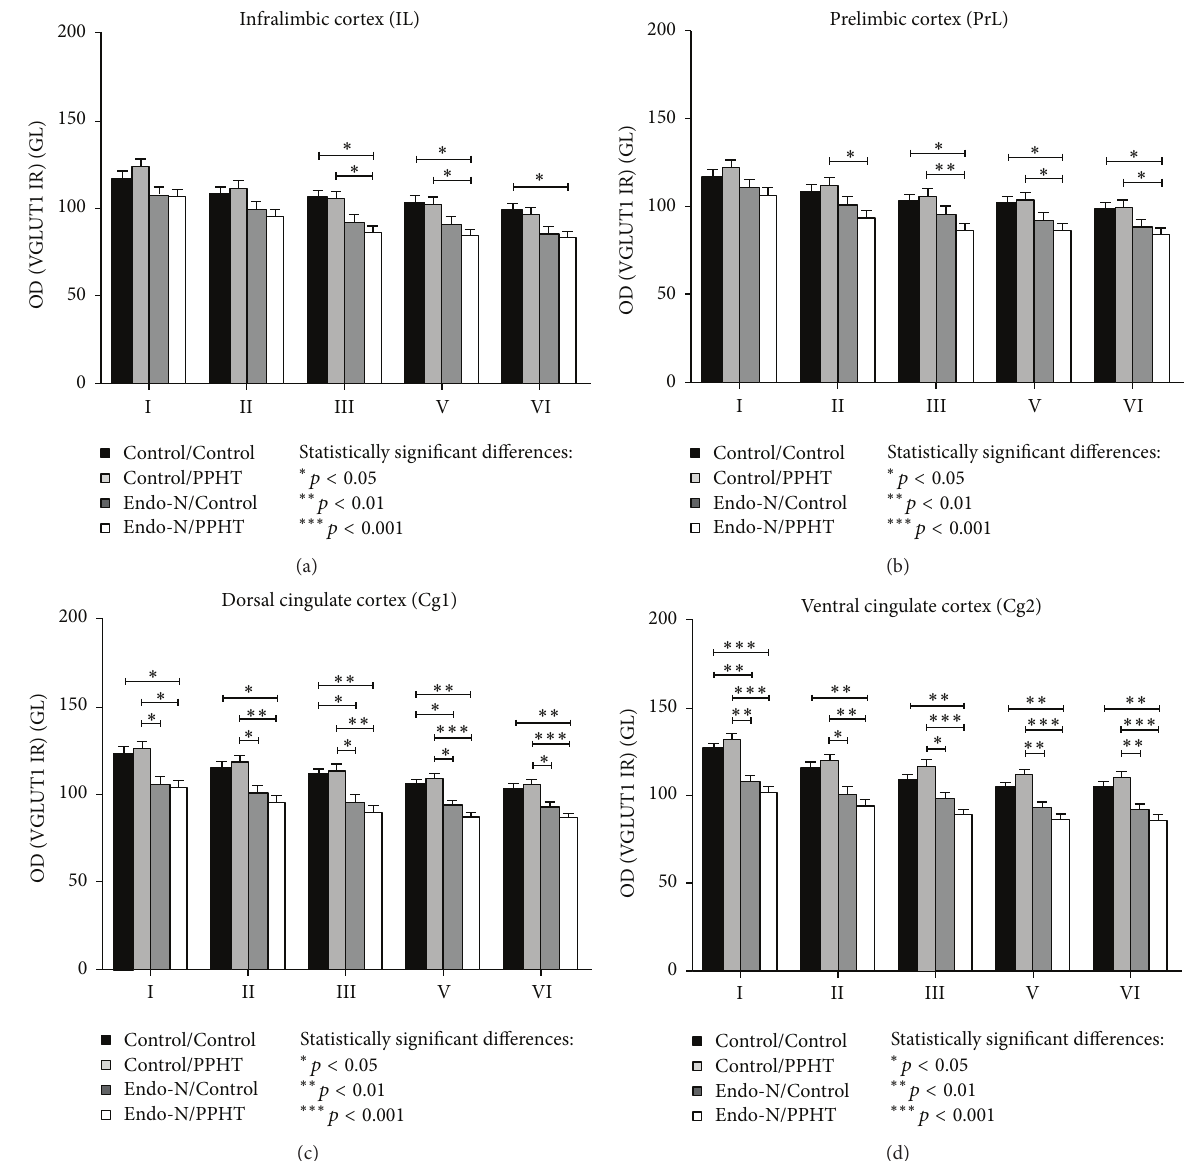
Figure 3: Graphs representing the changes in VGLUT1 neuropil expression after Endo-N and/or PPHT treatments in the different layers and regions within the mPFC. (a) Infralimbic cortex; (b) prelimbic cortex; (c) dorsal cingulate cortex; (d) ventral cingulate cortex. Six animals per group were analyzed. Error bars represent SEM and asterisks in bars indicate statistically significant differences between groups after univariate repeated measures ANOVA followed by multiple pairwise comparisons with Bonferroni’s correction ( ∗ 𝑝 < 0.05 , ∗∗ 𝑝 < 0.01 , and ∗∗∗ 𝑝 < 0.001 ). Roman numbers indicate cortical